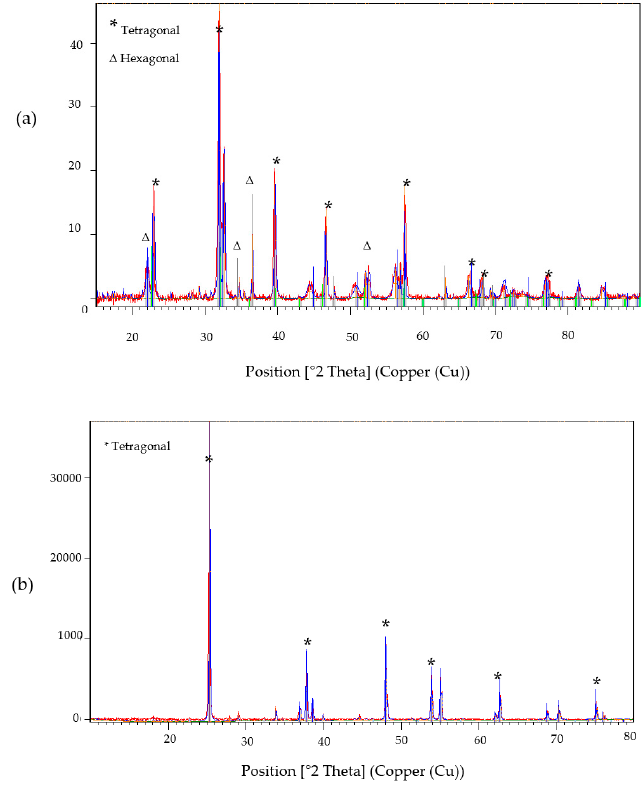
Figure 2. XRD patterns of 0.7PbZn 0.3 Ti 0.7 O 3 -0.3Na 2 TiO 3 : ( a ) PbZn 0.3 Ti 0.7 O 3 ; and ( b ) Na 2 TiO 3 .